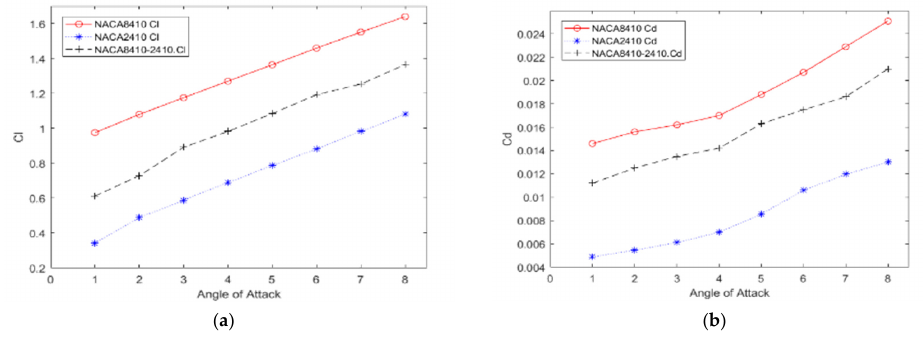
Figure 20. ( a ) 𝐶 (cid:3013) and ( b ) 𝐶 (cid:3005) of NACA2410, NACA8410, and NACA2410 to 8410 transition vs. AoA. Figure 20. ( a ) C L , ( b ) C D of NACA2410, NACA8410, & NACA2410 to NACA8410 transition vs. AoA.